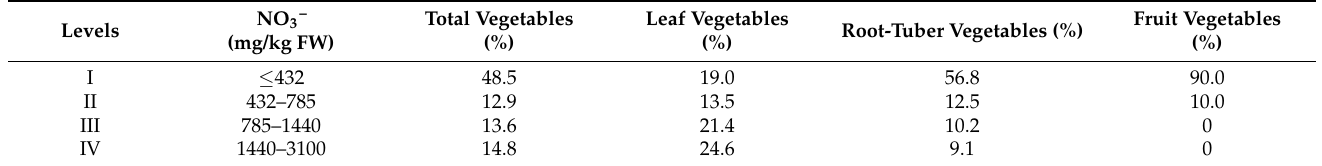
Table 3. Levels of nitrate contamination of the three vegetable groups in Shanghai, Southeast China.